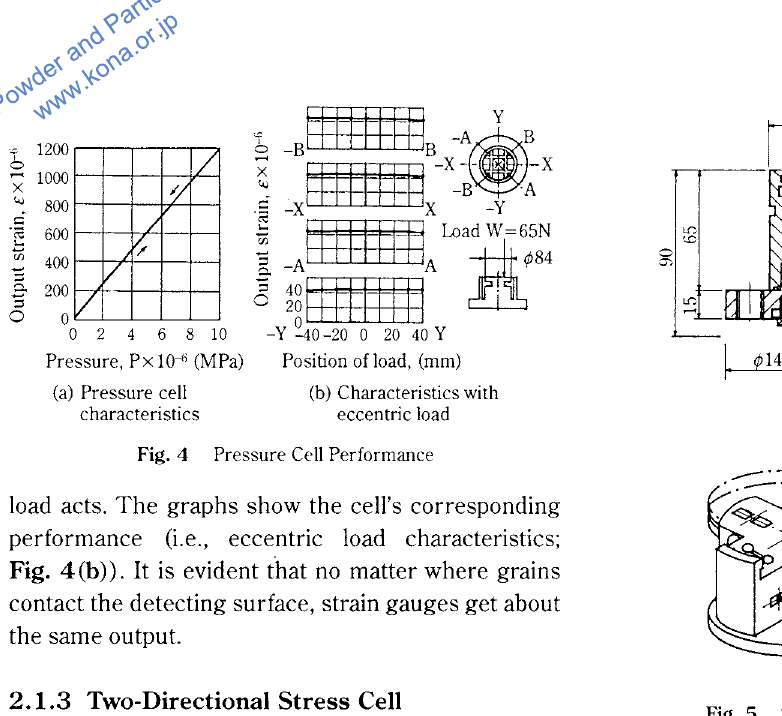
Strain gauges to detect pressure (actually fitted on the lower surface) Strain gauges to detect frictional stress Fig. 5 Structure of Two-Directional Stress Cell